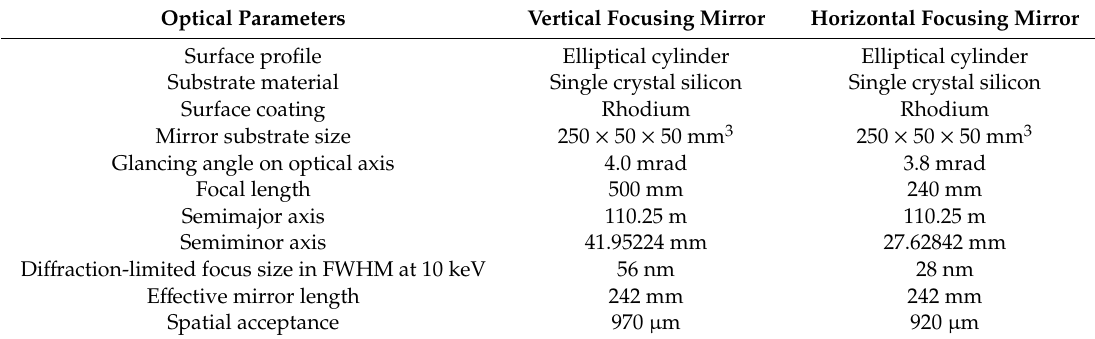
Table 1. Optical parameters of the focusing